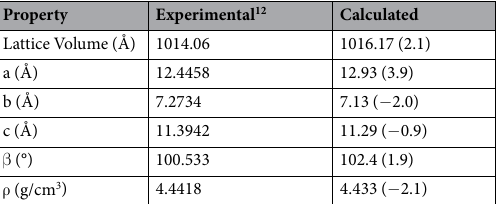
Table 1. Values of lattice constants and densities for zirconolite and pyrochlore materials found in the literature and after structural relaxation using GULP. * Percent variation in parentheses.